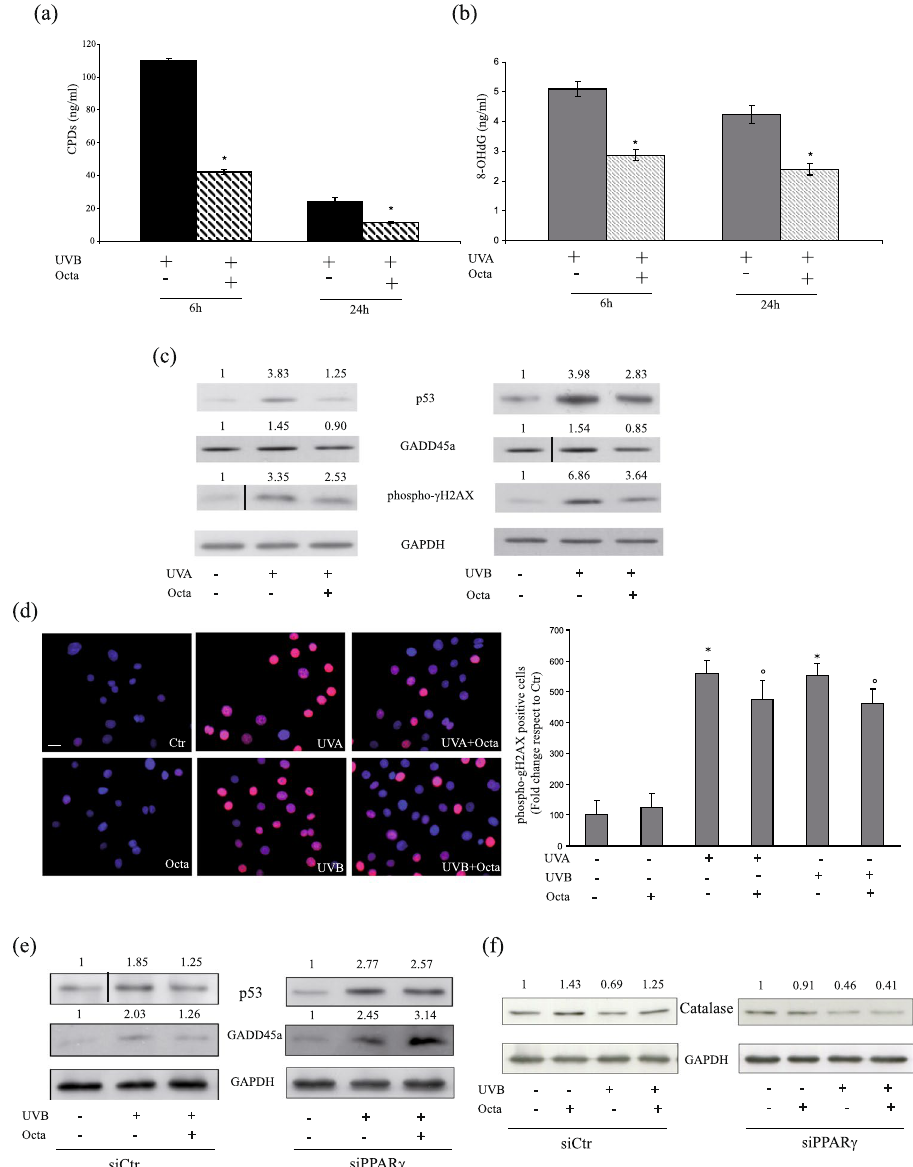
Figure 3. Octa protects NHKs from UVA and UVB-induced DNA damage, through PPAR γ activation. ELISA analysis of the amount of CPDs ( a ) and 8-oxodG ( b ) remaining in NHKs pre-treated with 90 µ M Octa for 24 h and irradiated with UVA 10 J/cm2 or UVB 25 mJ/cm2. DNA was extracted 6 and 24 h later. The values reported represent means ± SD of three independent experiments performed in duplicate. * p < 0,001 (vs UVB- irradiated cells), * p < 0,005 (vs UVA-irradiated cells) ( c ) NHKs were pre-incubated with 90 µ M Octa for 24 h and then irradiated with UVA 10 J/cm2 or UVB 25 mJ/cm2. Proteins were extracted 24 h later and Western blot analysis of p53, GADD45a and phospho- γ H2AX protein expression was perfomed. GAPDH was used as a loading control. Results refer to three independent experiments. Representative blots are shown. Densitometric scanning of band intensities was performed to quantify the change of protein expression (control value taken as one fold in each case). ( d ) Immunofluorescence analysis of phosphorylated histone H2AX expression (red signal) in NHKs pre-treated with 90 µ M Octa for 24 h and irradiated with UVA 10 J/cm2 or UVB 25 mJ/cm2. Corresponding quantitative analysis of the fluorescence signal evaluated by counting the number of positive cells/total cells. Nuclei are counterstained with DAPI (blue). Scale bar: 20 µ m. The values reported represent means ± SD of two distinct experiments. * p < 0,001 (vs non-irradiated cells), °p < 0,005 (vs UV-irradiated cells). Western blot analysis of p53, GADD45a ( e ) and catalase ( f ) protein expression using lysates obtained from NHKs transfected with siPPAR γ and siCtr, exposed for 24 h to 90 µ M Octa and irradiated with UVA 10 J/ cm2 or UVB 25 mJ/cm2. Proteins were extracted 24 h later. GAPDH was used as a loading control. Results refer to three independent experiments. Representative blots are